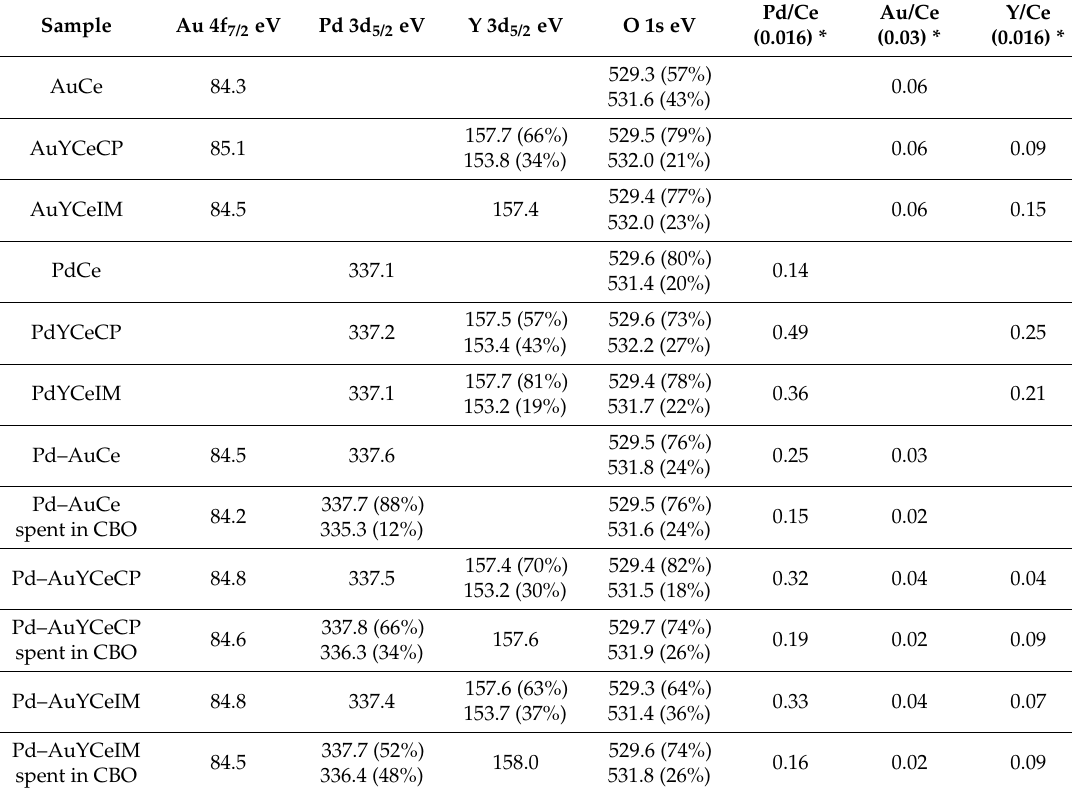
Table 3. X-ray photoelectron spectroscopy (XPS) data in terms of binding energies and atomic